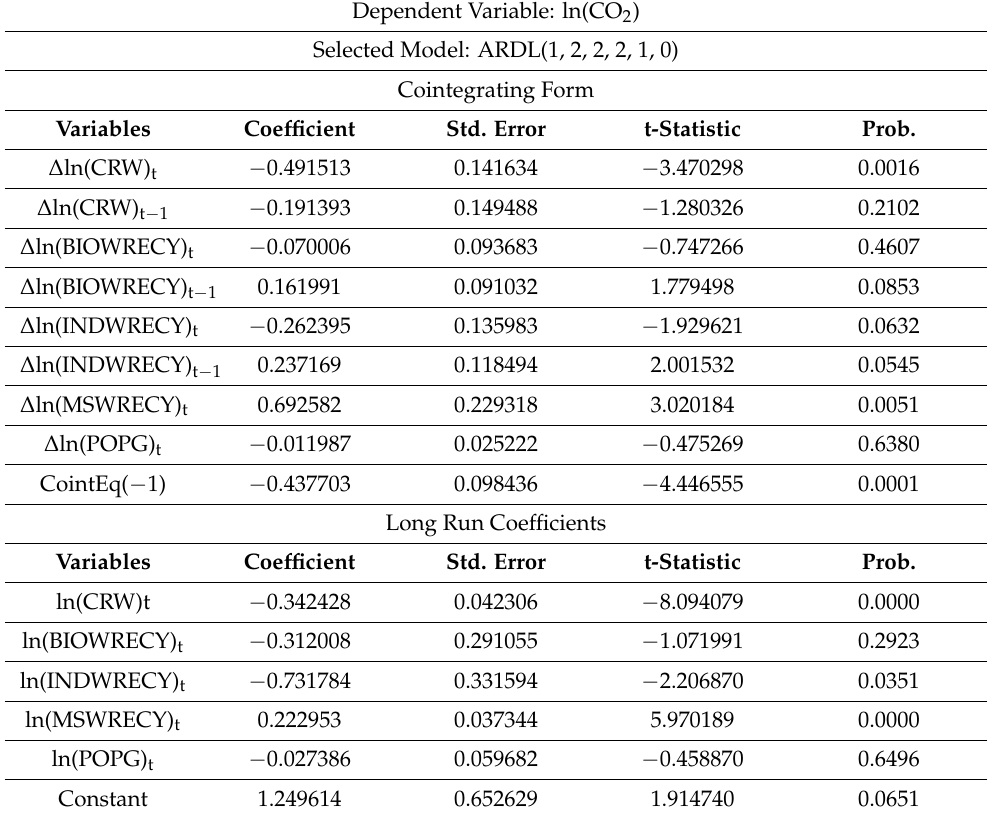
Table 6. ARDL short- and long-run estimates.